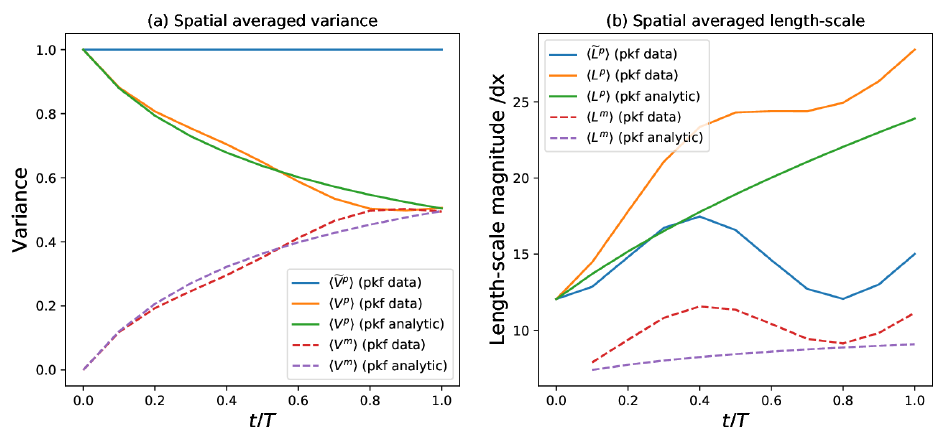
Figure 6. Time evolution of the spatial average over the domain of the predictability-error variance (a) and length scale (b) , computed from the PKF for the nature (blue) and the numerical model (orange). The analytical PKF approximation (Eq. 48) for the numerical model is in green. The model-error variance (Eq. 29a) and length scale (Eq. 49) are also represented (in dashed lines) for the spatial averaged of the PKF results shown in Fig. 7a and b (red), and the analytical approximation